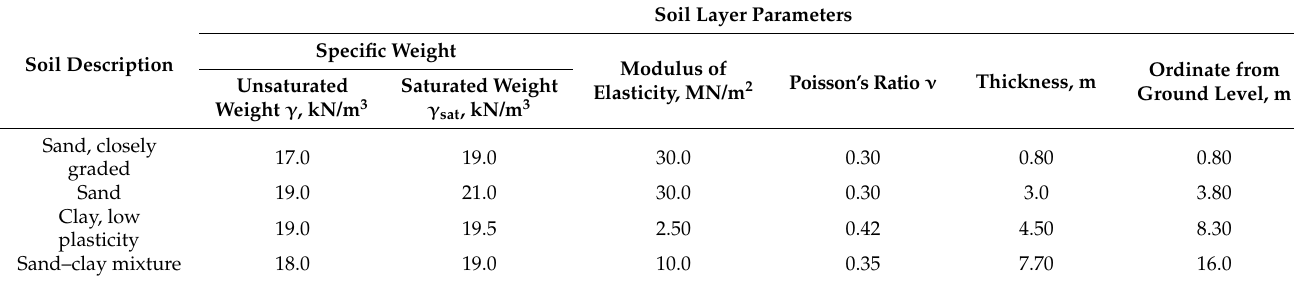
Table 4. Soil materials of soil type II.